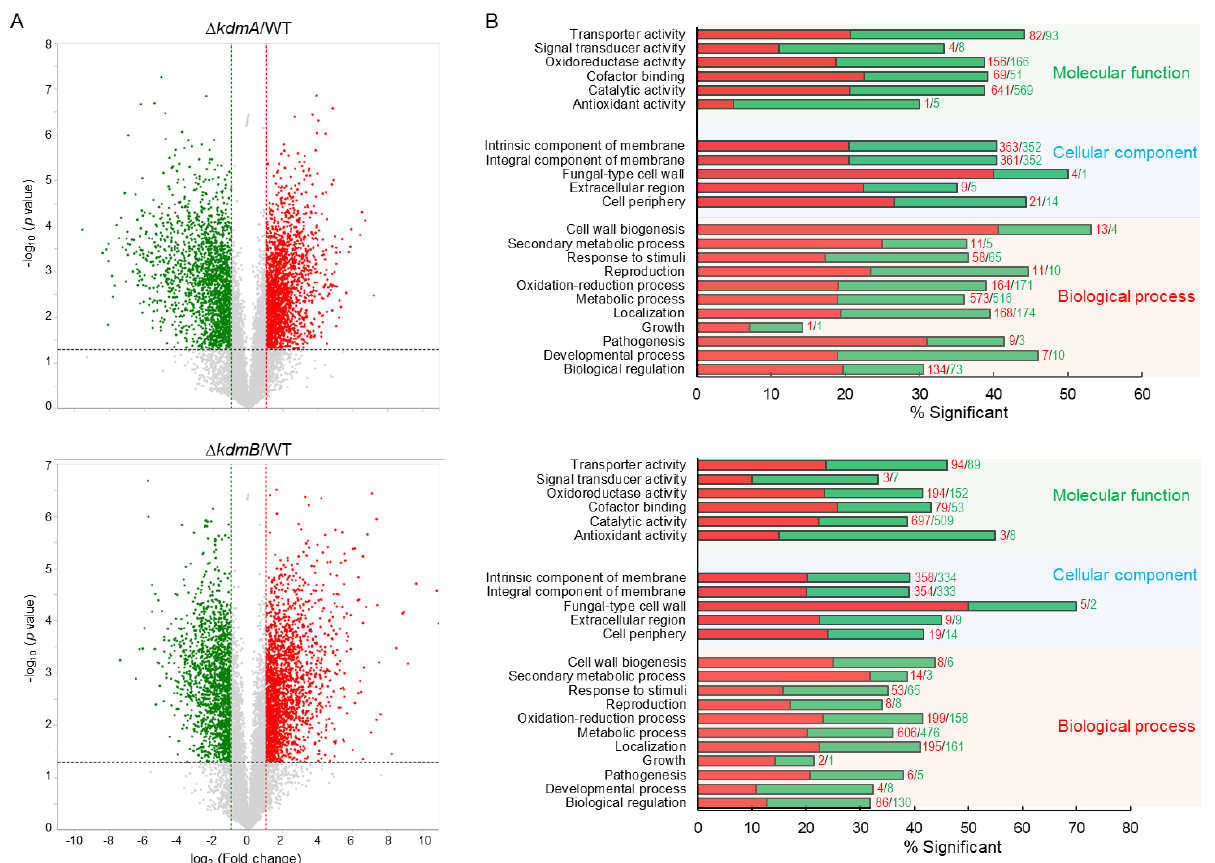
Figure 7. Genome-wide expression analyses of the ∆ kdmA and ∆ kdmB . ( A ) Volcano plot showing the fold change (x-axis) and p -value (y-axis) of genes sequenced in ∆ kdmA (upper) and ∆ kdmB (lower). Red and green dots denote up- and downregulated genes, respectively. ( B ) Functional annotation histograms of DEGs in ∆ kdmA (upper) and ∆ kdmB (lower). The red bars represent genes whose mRNA levels increased in the mutant, whereas the green bars represent those genes whose mRNA levels decreased in the mutant strain.